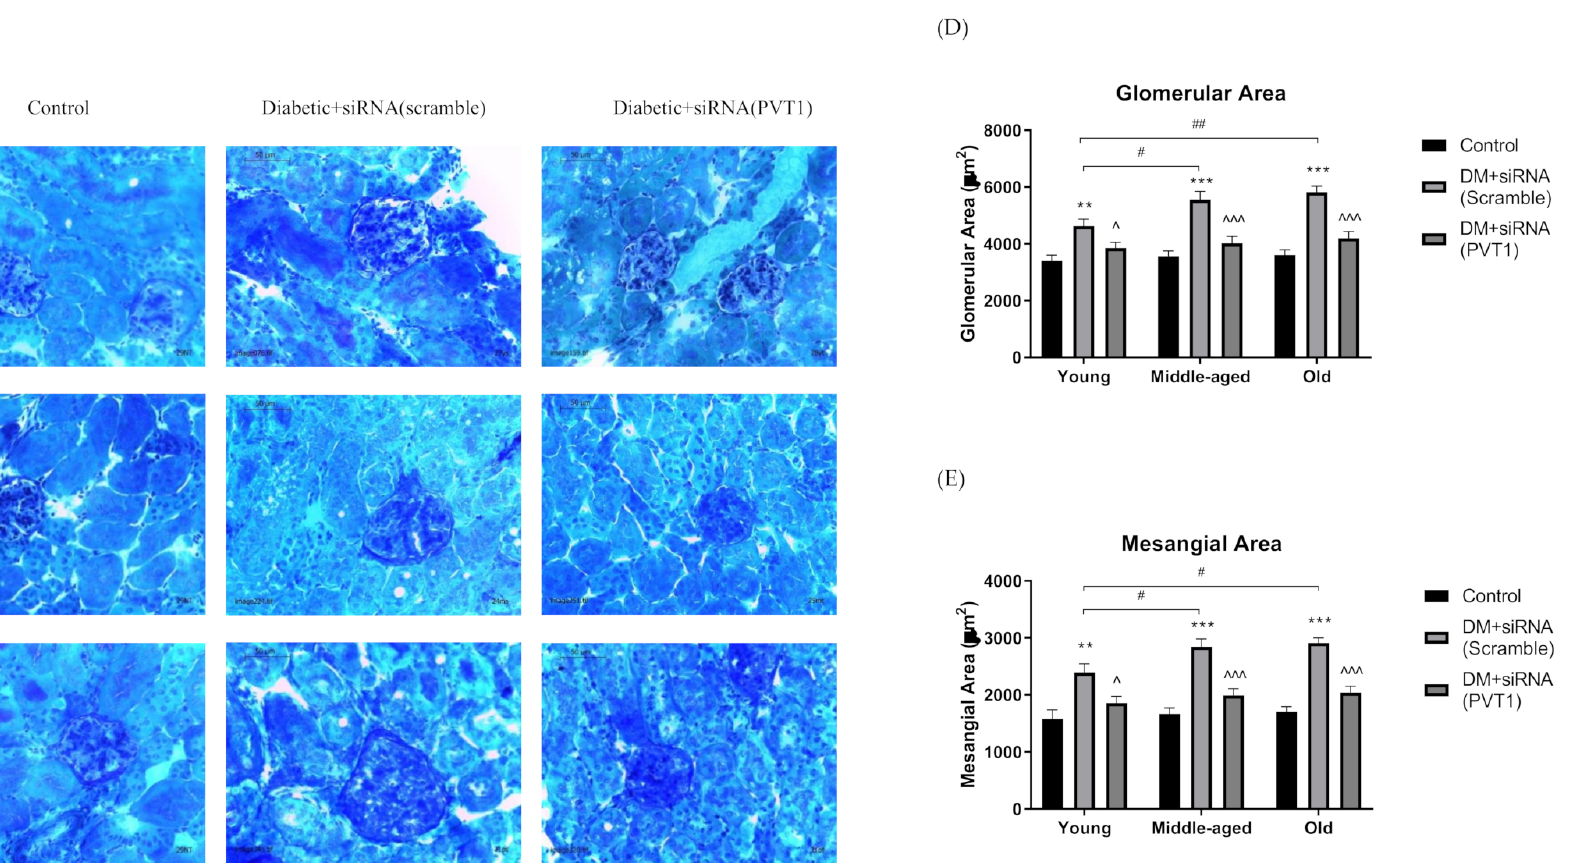
Figure 2. Microscopic images of kidney sections of siRNA-treated diabetic and control mice of different age groups: ( A ) young, ( B ) middle-aged and ( C ) old. Diabetic mice were treated with either scramble-siRNA (DM + siRNA (scramble)) or PVT1-siRNA (DM + siRNA (PVT1)), whereas control mice were normal mice without siRNA injection (Control). The kidney sections were stained with periodic acid Schiff (PAS) followed by Mayer’s hematoxylin and viewed under 40X. ( D ) Glomerular area and ( E ) mesangial area were semi-quantified using Image-J software. Data were presented as means ± SEM, n = 6. A p -value < 0.05 was considered statistically significant using one-way ANOVA with Tukey post-test (* p < 0.05, ** p < 0.01, *** p < 0.001 vs. age-matched control; ˆ p < 0.05, ˆˆˆ p < 0.001 vs. age-matched DM + siRNA (scramble); # p < 0.05 , ## p < 0.01 vs. young DM + siRNA